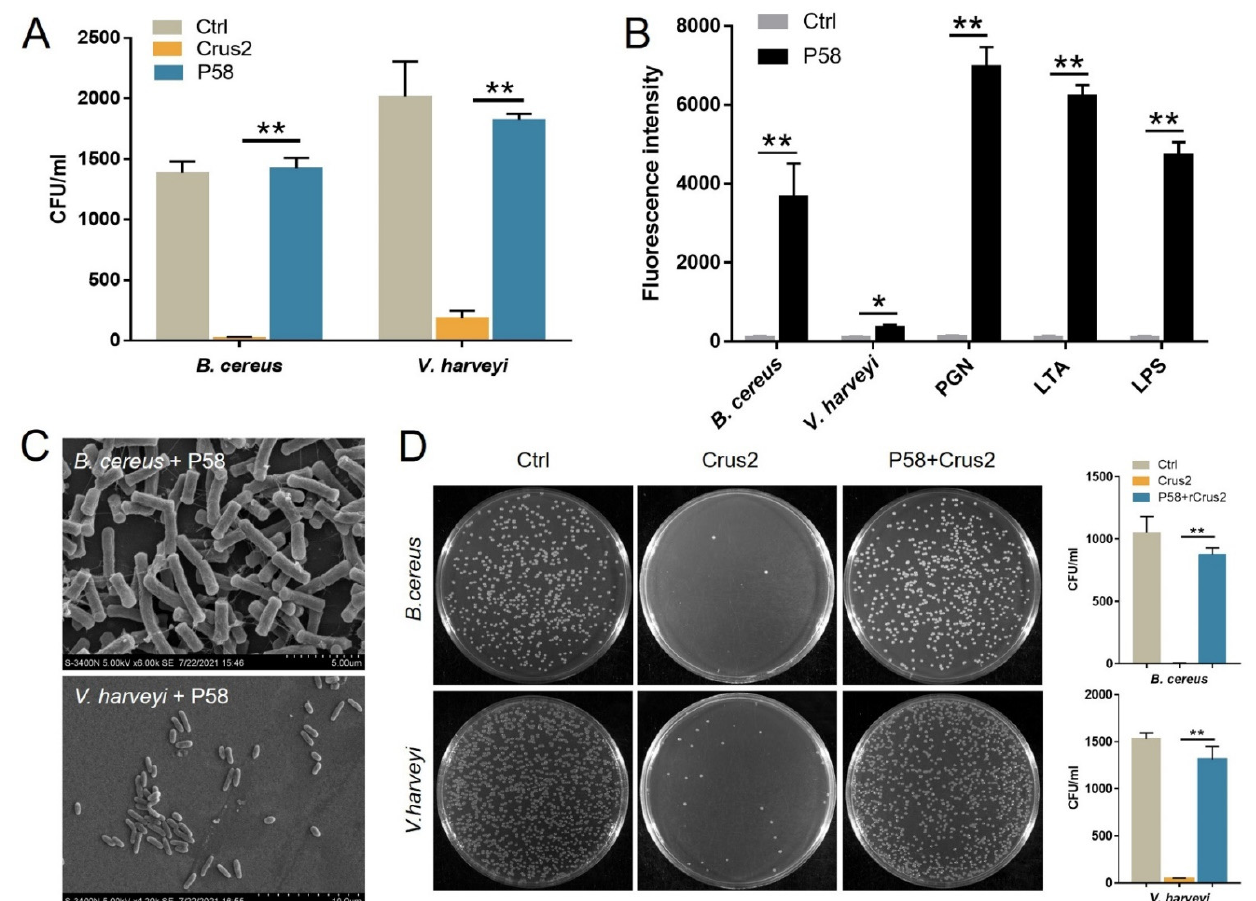
Figure 5. The bacterial binding and bactericidal activities of P58. ( A ) Bacillus cereus and Vibrio harveyi were treated with or without (Ctrl) Crus2 or P58 for 1 h. After treatment, bacterial growth on MH agar plates was determined. CFU, colony-forming units. ( B ) Bacteria, peptidoglycan (PGN), lipoteichoic acid (LTA), and lipopolysaccharide (LPS) were each incubated with or without (Ctrl) FITC-labeled P58, and the binding was determined by measuring fluorescence intensity. ( C ) B. cereus and V. harveyi were incubated with P58 for 2 h. After incubation, scanning electron microscopy was applied for structural observation. ( D ) Crus2 was incubated with B. cereus and V. harveyi that had been pre-treated with or without (Ctrl) P58. After incubation, bacterial growth on MH agar plates was determined. The CFU numbers are shown in the graphs. Data are the means triplicate experiments and shown as ± SD. ** and * represent p < 0.01 and p < 0.05, respectively (Student’s t test).